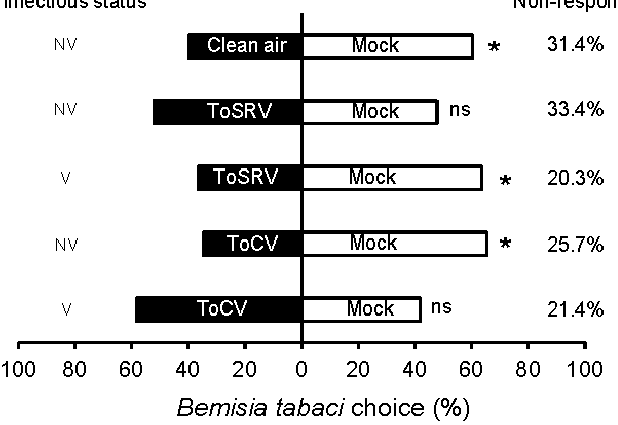
Figure 1. Percentage of whiteflies (%) responding to volatiles coming from different plant sources connected to a Y ‐ tube olfactometer with a continuous active air flow. Individual adult whiteflies were released in the principal arm and their response was recorded in a 15 min time interval. A positive response was considered when whiteflies remained for 3 min across the border line of the lateral tubes. A total number of 70 replicates (whiteflies) per test were used. V: viruliferous whiteflies; NV: non ‐ viruliferous; ns: not significant; *: p < 0.05.